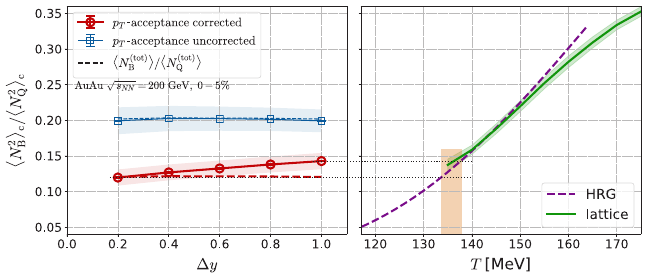
/ N 2 N 2 B (cid:30) c Q (cid:30) c (cid:31) (cid:31) = 200 GeV and its com- NN